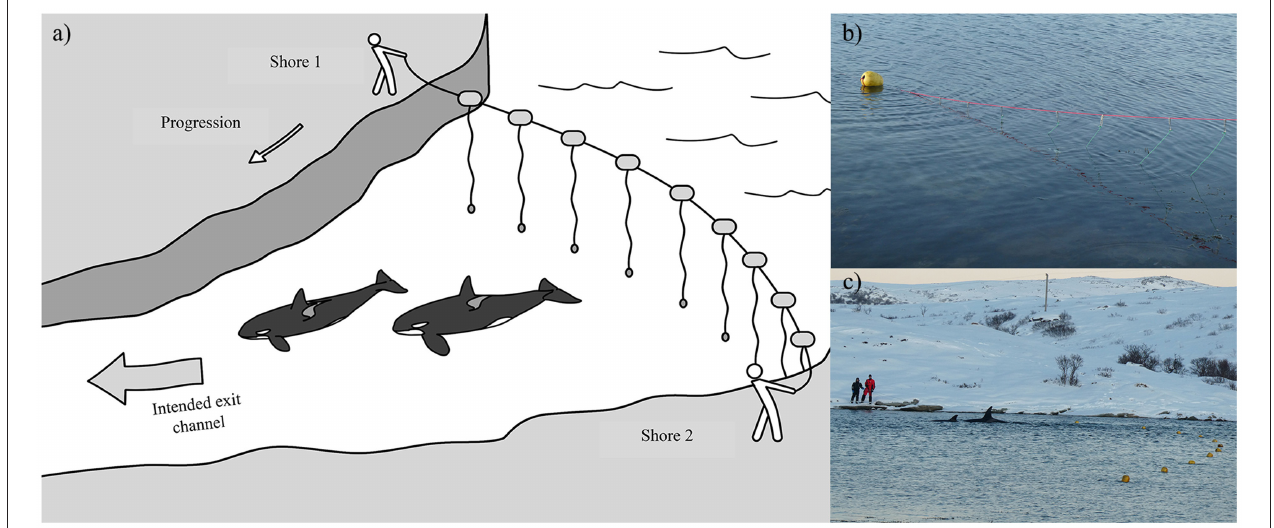
FIGURE 6 | (a) Illustration of how a “hukilau” was used in Cases #15 and 19 as a means to guide the entrapped killer whales toward the exit channel that led to open water (Illustration: Frédérique Lucas); (b) Structure of the hukilau, made of a main line with floats stretched across the bay and attached 2 m-sinking hanging lines every meter (Case #19); (c) Photograph showing the team stationed on the opposite shore moving killer whales from the entrapment site by pulling the hukilau toward the intended exit channel (Case #19) (Photographs: Tor Johansen,